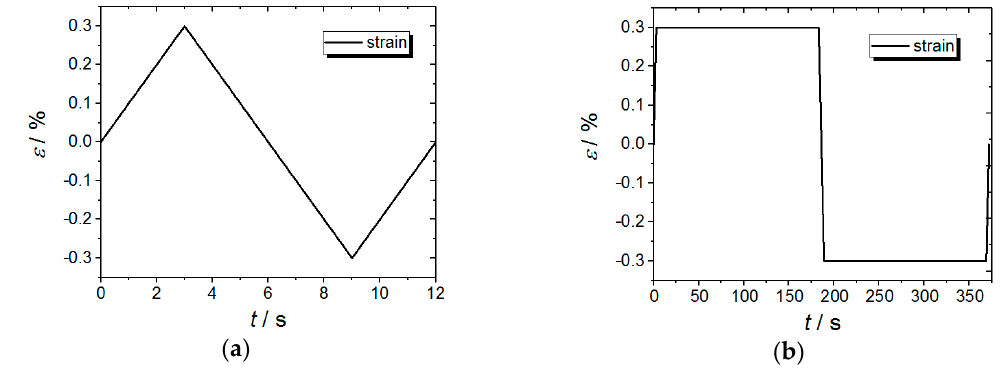
Figure 3. Schematic representation of loading waveform for one cycle of ( a ) a low-cycle fatigue (LCF)-test and ( b ) a LCF-test with a hold time of 3 min in tension and compression.